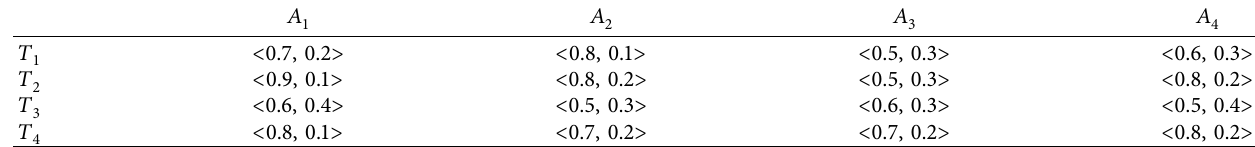
Table 1: Normalized intuitionistic fuzzy decision matrix.